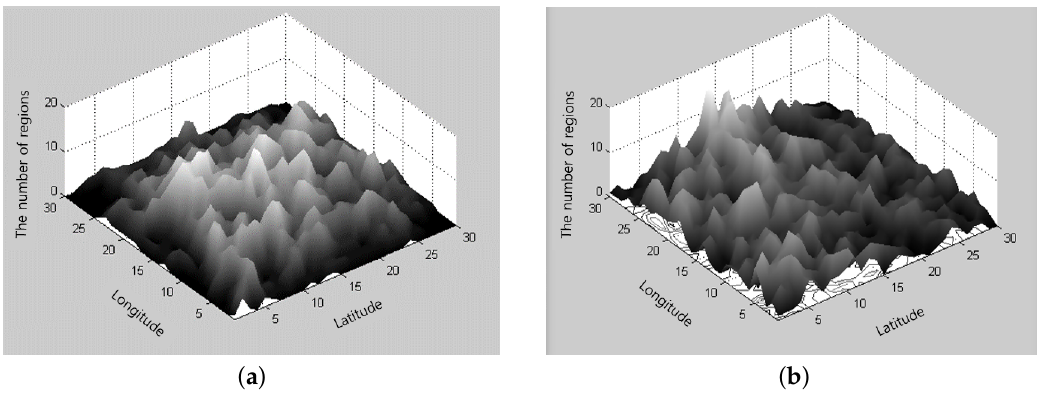
Figure 2. The distribution of visits (the bright color indicates the high rate of revisits): ( a ) Random Waypoint model; and ( b ) Pheromone Repel